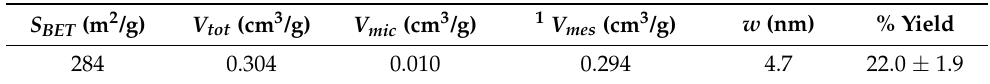
Table 1. Textural parameters calculated from nitrogen adsorption isotherms and carbonization yield of TPNi.